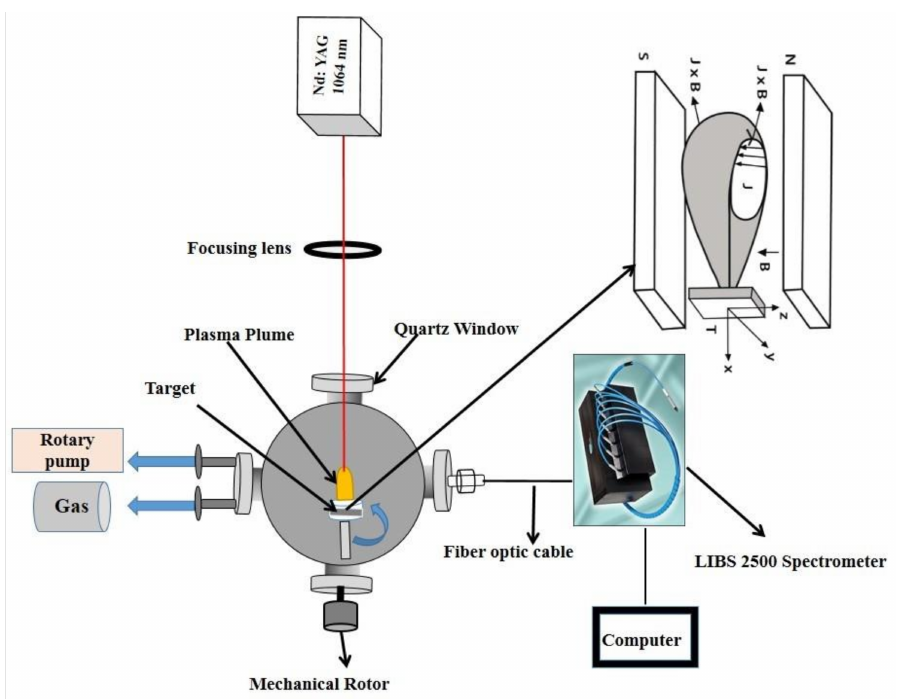
Figure 1. Schematic of the experimental setup for investigating the impact of magnetic fields on the laser-induced breakdown spectroscopy of Mg alloy plasma produced with an Nd: YAG